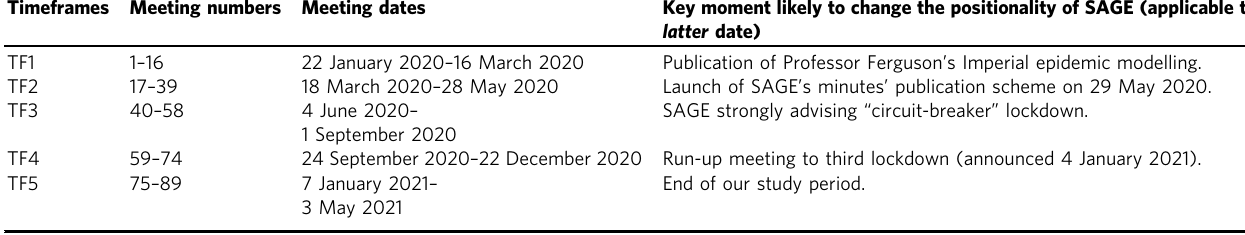
Table 1 Timeframes used for